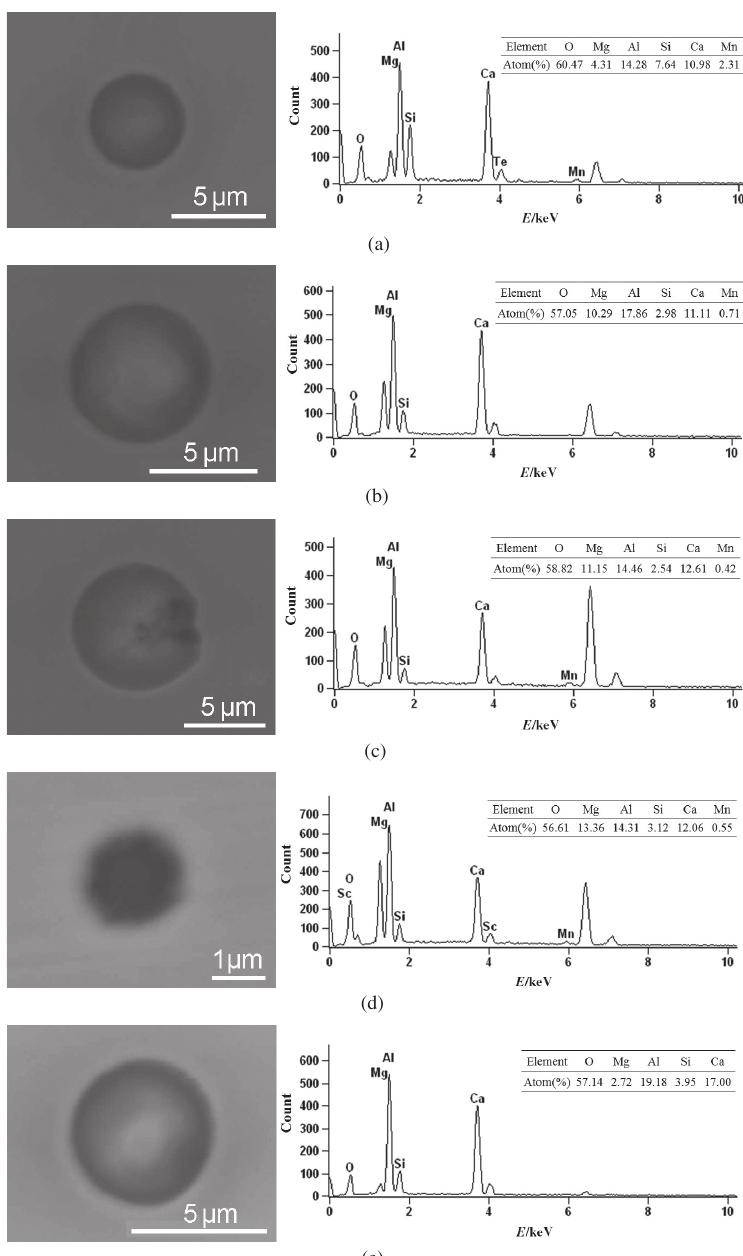
Figure 2 : Typical morphology and EDS of inclusions detected in steel samples under slag No. 1 – 5. (a) Slag No. 1; (b) slag No. 2; (c) slag No. 3; (d) slag No. 4; (e) slag No.